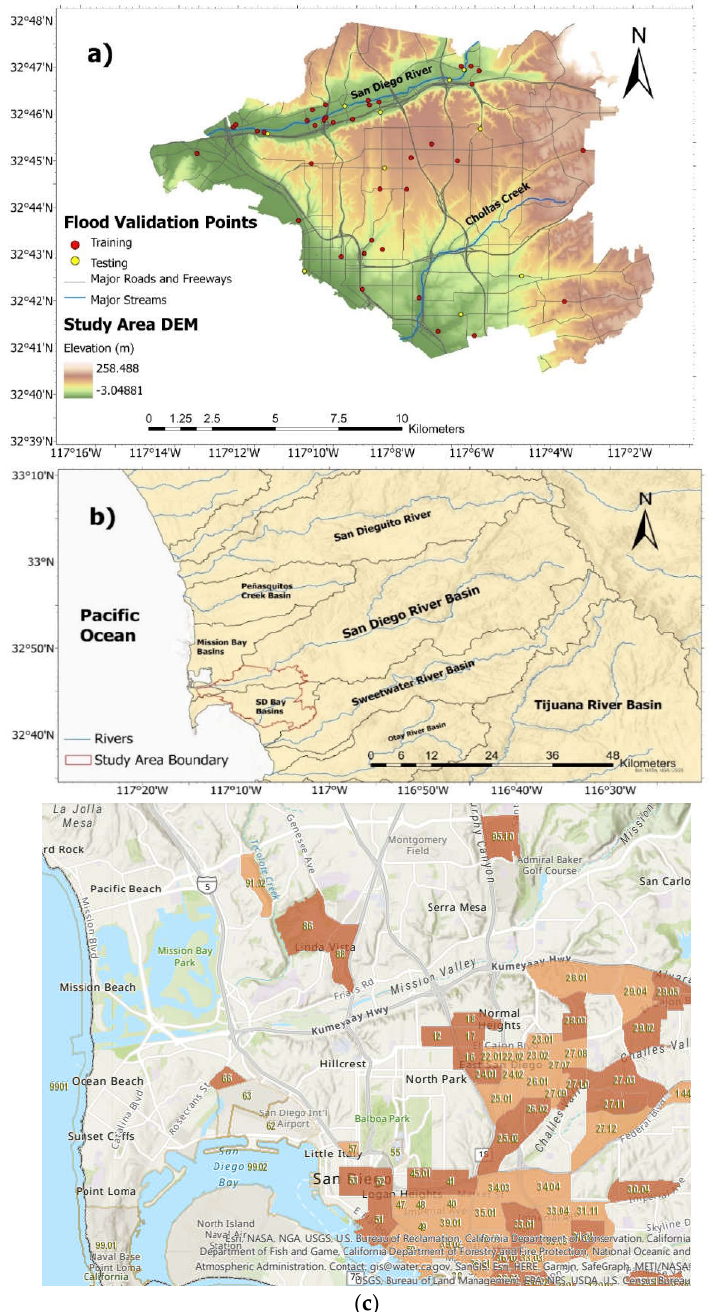
Figure 2. Figures of location and geographic context of study area. ( a ) shows study area DEM, network of major roads, major streams, and validation points. ( b ) shows hydrologic and geographic context of region around the study area. ( c ) Disadvantaged communities by census tract in the study area as designated by CalEnviroScreen.3 (light orange: Disadvantaged, dark orange: Severely Disadvantaged).